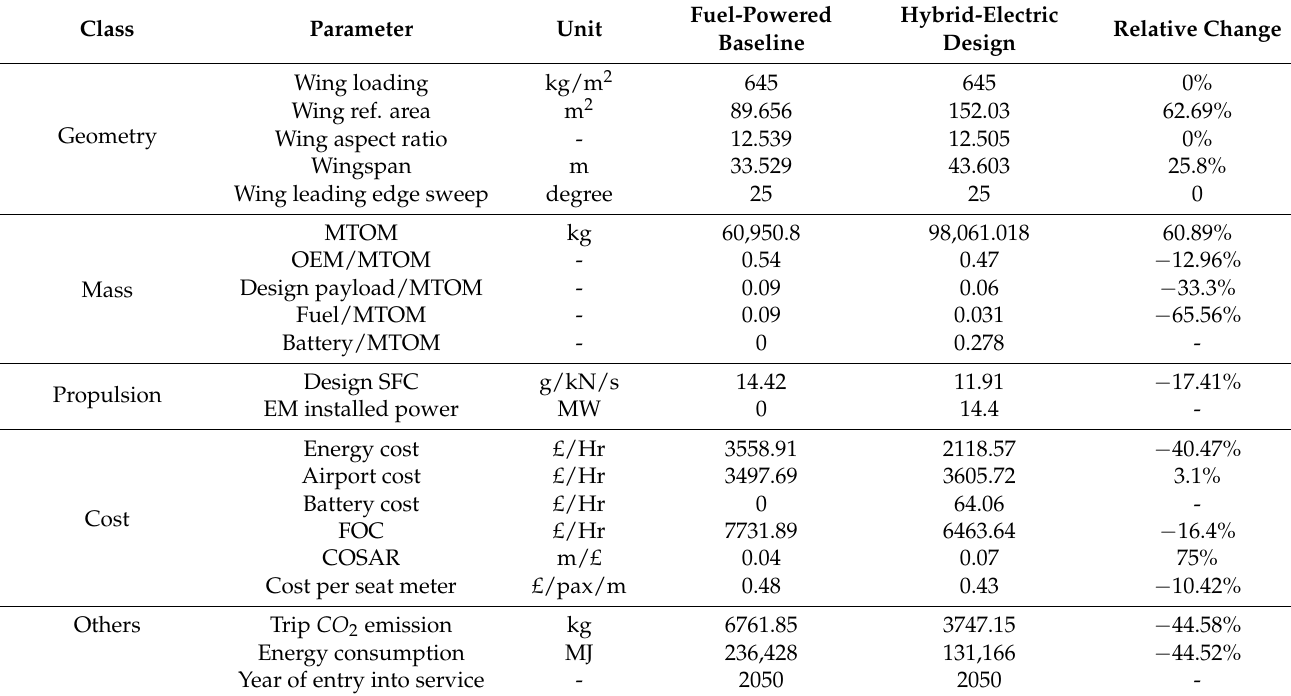
Table 5. Performance comparison between the advanced fuel-powered aircraft with the optimum hybridised aircraft in this